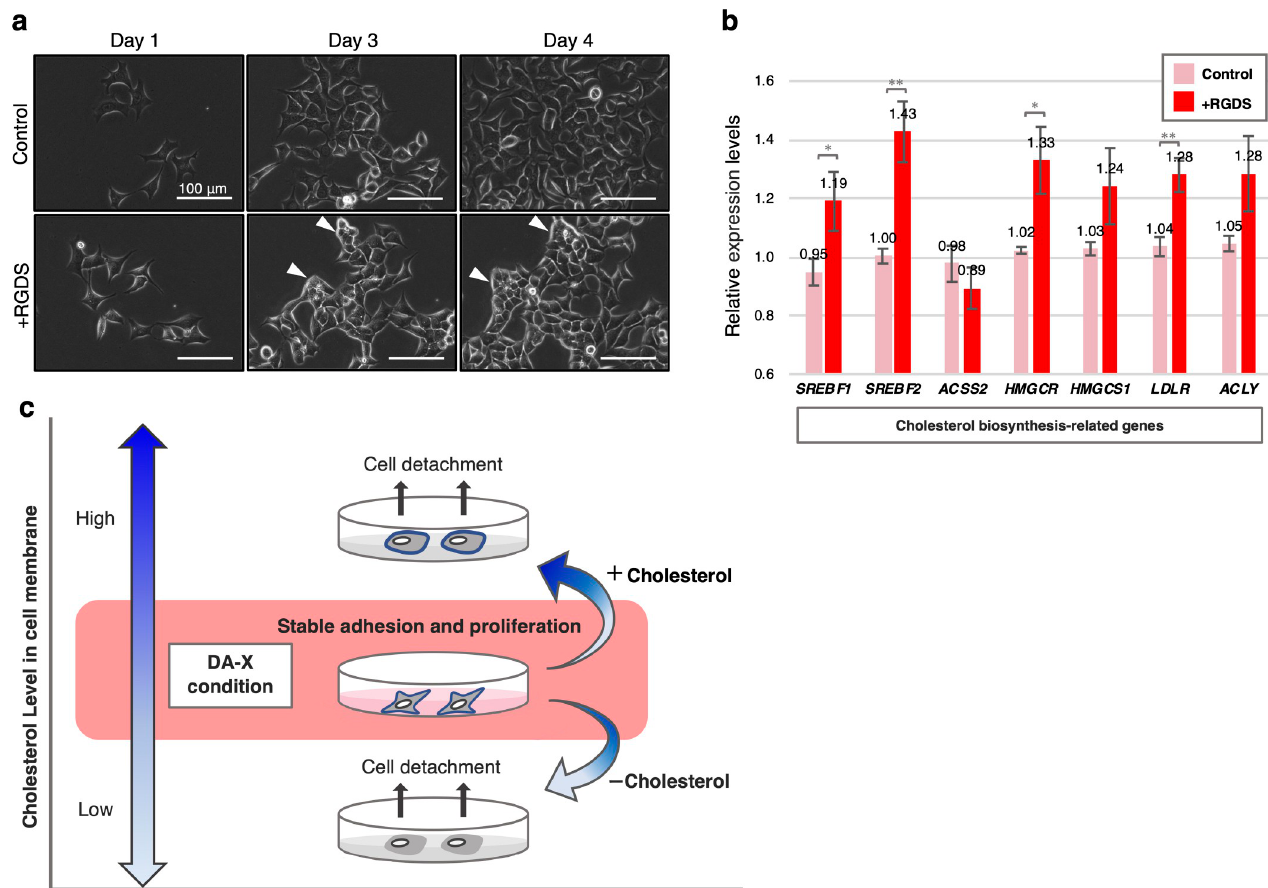
Fig 4. Involving fibronectin in down-regulation of cholesterol biosynthesis-related genes expression in DA-X condition. a, Representative images of HeLa cells under RGDS peptide treatment in DA-X culture condition. After exposed to RGDS peptide for 3 days, retracting the pseudopodia of cells was observed accompanied by tightly association between neighbor cells. Scale bar, 100 μ m. White arrowheads indicate cells with the retraction of pseudopodia. b, Quantitative PCR analysis of expression of de novo cholesterol biosynthesis-related genes. HeLa cells exposed to RGDS peptide for 4 days under DA-X condition were collected for further gene expression analysis. Error bars indicate s.d. (n = 3, biological replicates). t-test, �� p < 0.01 and � p < 0.05. c, Schematic representation summarizing the appropriate range of cholesterol contents on cell membrane in serum-free medium condition for cell adhesion and